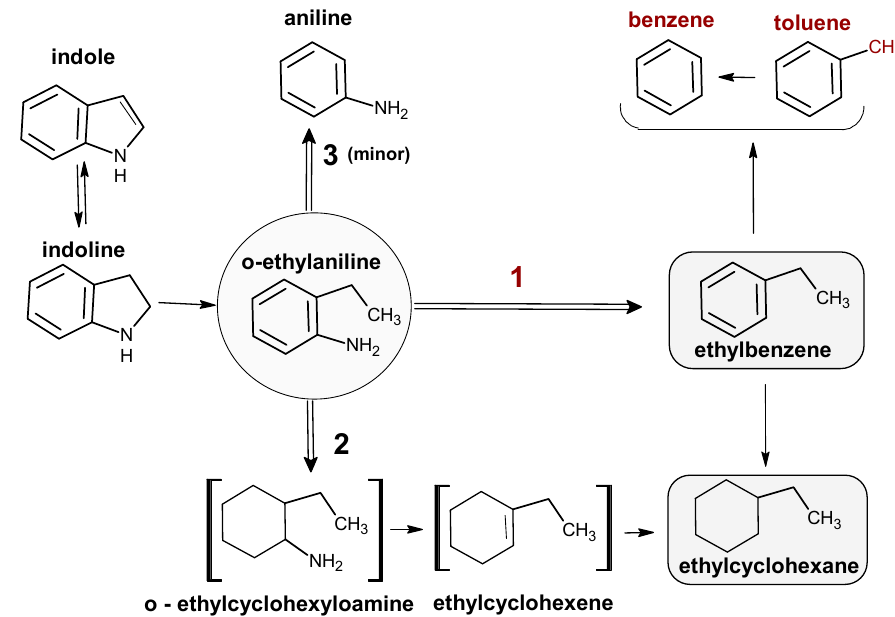
Scheme 1. Possible reaction pathways of the hydrodenitrogenation of indole over bulk Mo 2